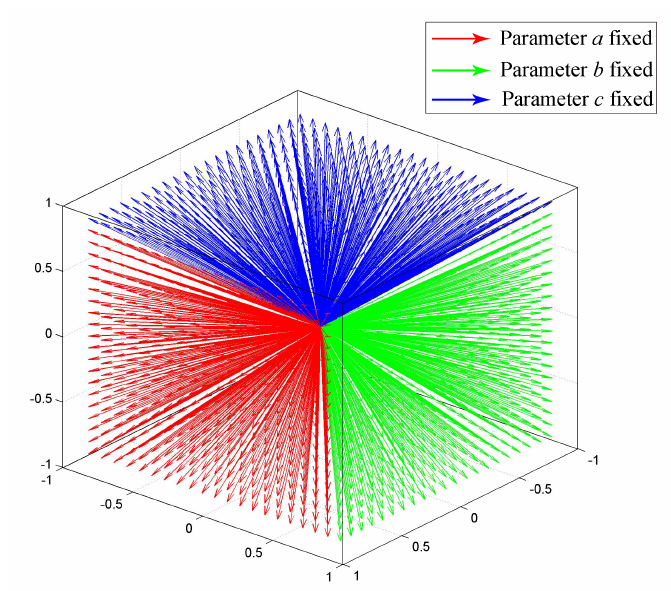
Figure 4. Illustration of normal vectors. All of the possible normal vectors of Π are approximately uniformly distributed in the first octant. Here, the discretized resolution of the plane parameters is